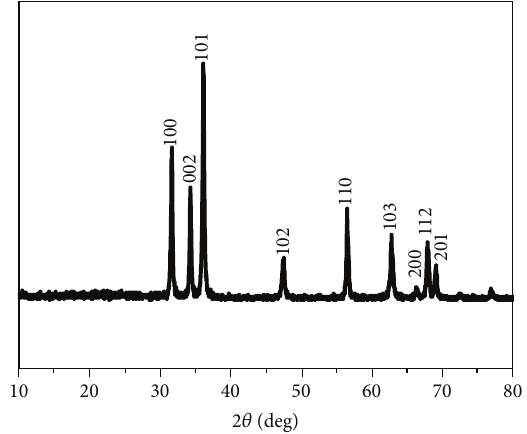
Figure 2: XRD pattern of ZnONPs.